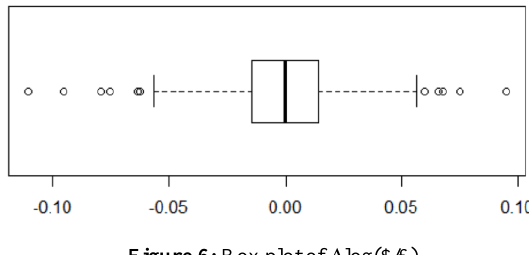
Figure 6: Box plot of ∆log($/£)